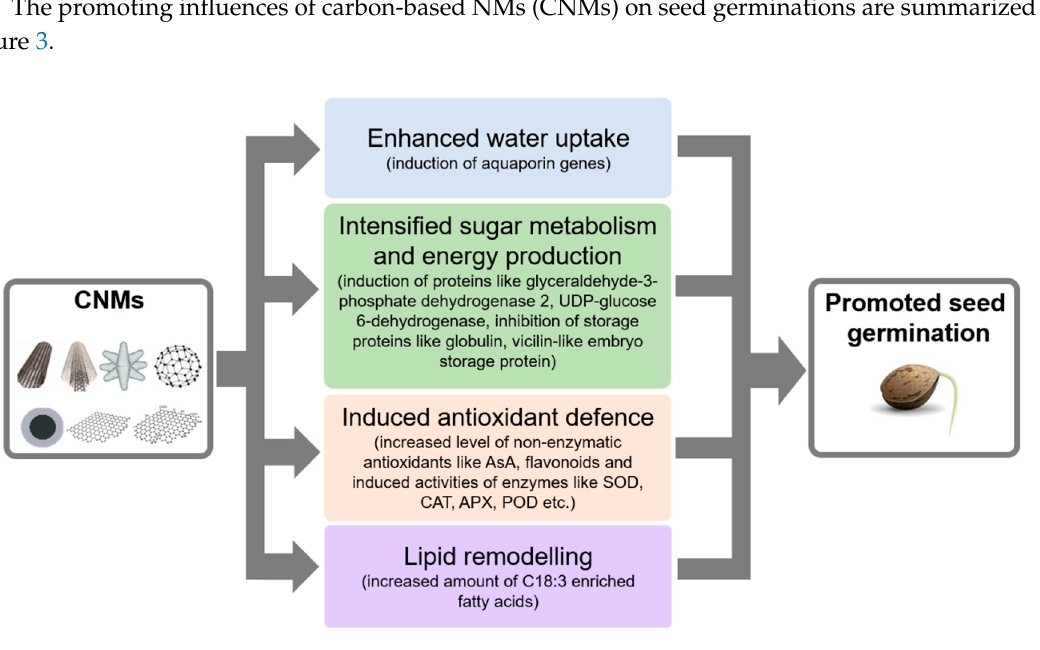
Figure 3. Biochemical and molecular mechanisms of the germination-promoting effect of carbon nanomaterials (CNMs) described so far. Upon CNM exposure, enhanced water uptake, intensified sugar metabolism / energy production, induced antioxidant defense and the remodeling of membrane lipids in seeds have been described in different experimental systems. See details in the text.